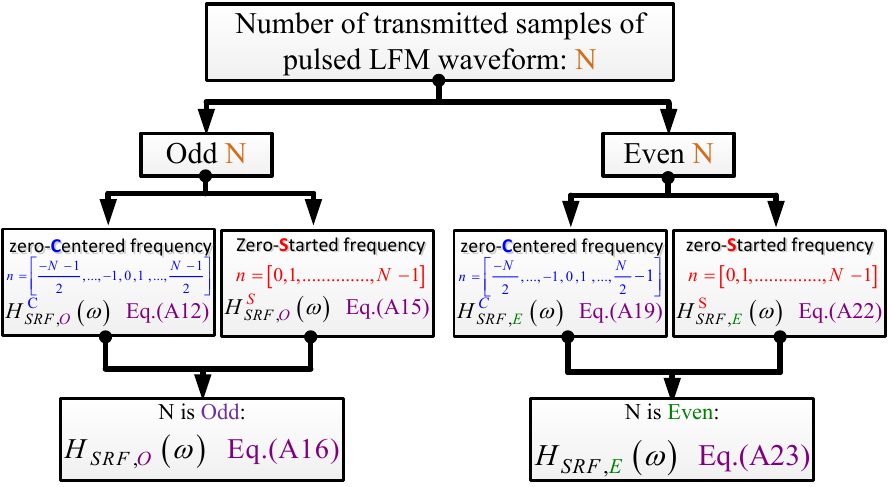
Figure A1. Generation of the frequency response of SRF for even and odd values of N